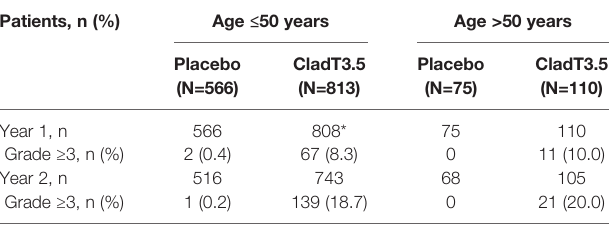
( Table 4 ). The most common viral and bacterial infections with cladribine tablets 3.5 mg/kg treatment were (Age ≤ 50 vs. Age >50 TABLE 3 | Incidence of Grade ≥ 3 lymphopenia in years 1 and 2 by age group. Patients, n